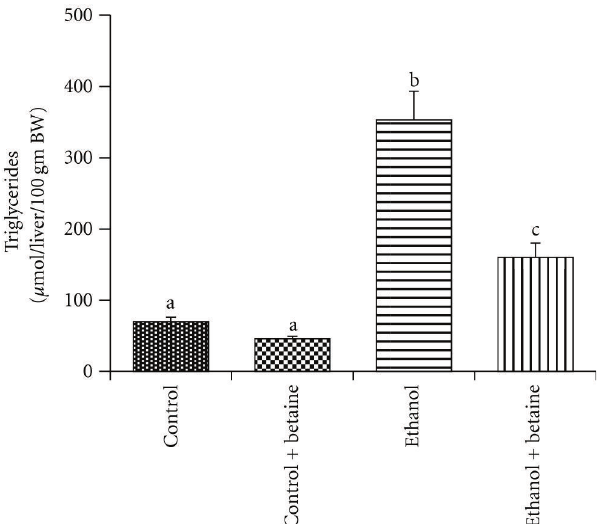
Figure 3: Betaine prevents the chronic ethanol-dependent decrease in the hepatic SAM:SAH ratio. Liver SAM and SAH levels were determined by HPLC analysis, and the SAM:SAH ratio was calculated as previously described [14]. Data represent the mean ± S.E.M. for n = 8 animals per group. Values not sharing a common letter are statistically di ff erent, P < 0 .